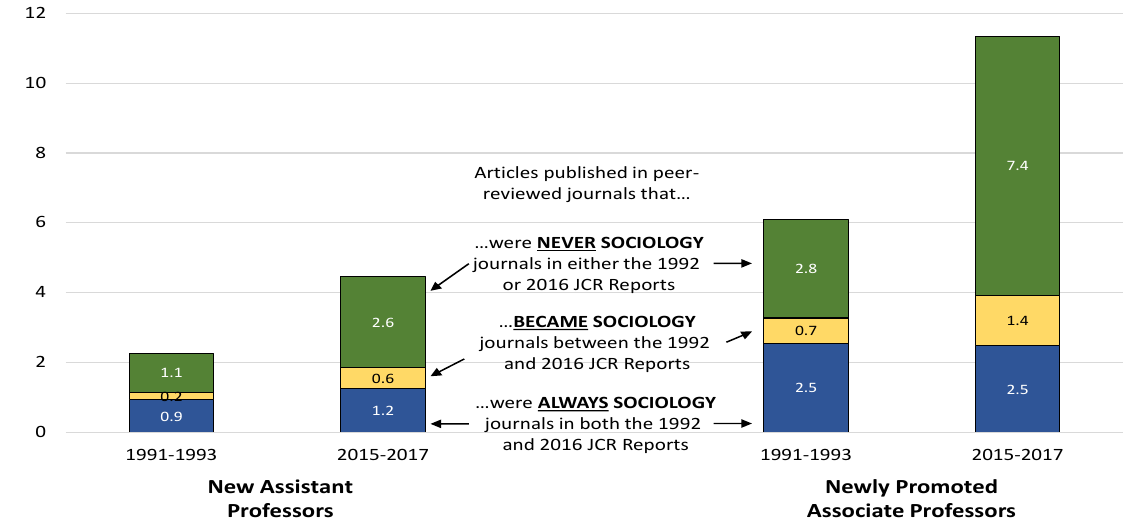
Figure 9: Articles published in journals classified as “sociology” in the 1992 and 2016 Journal Citation Reports by rank and year.